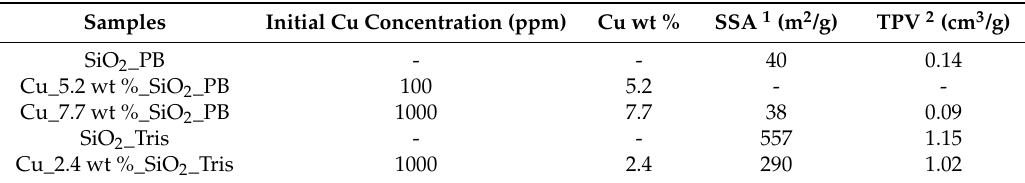
Table 1. Samples coding, textural characteristics and final metal loadings.